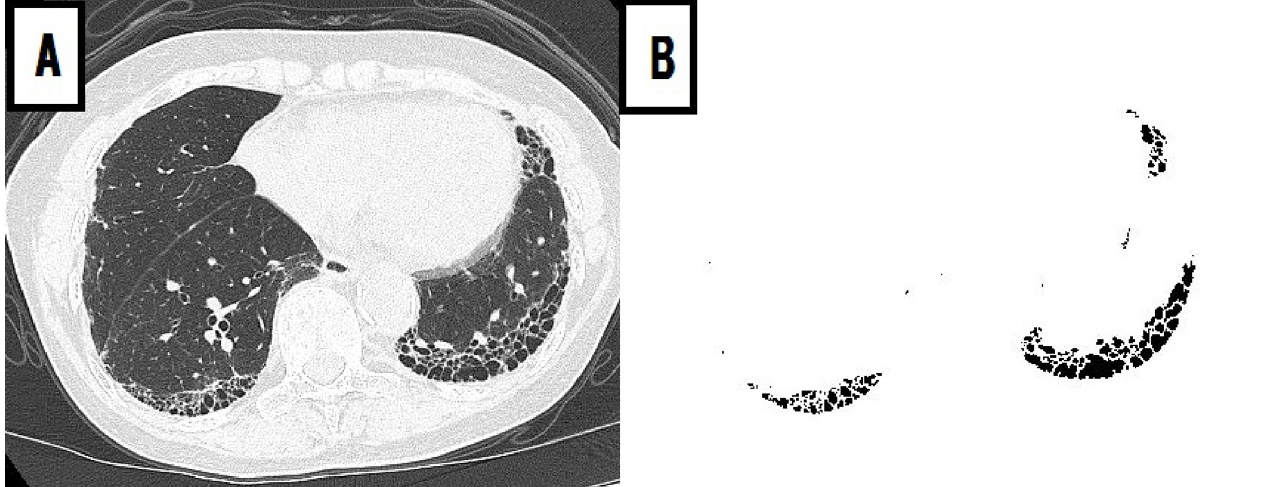
Fig 1. Honeycombing area detected by quantitative CT analysis. A 76-year-old man with idiopathic pulmonary fibrosis. (A) Original CT image was acquired at the level of the lower lungs using the lung window setting. (B) Honeycombing area was detected by quantitative CT analysis at the same level.